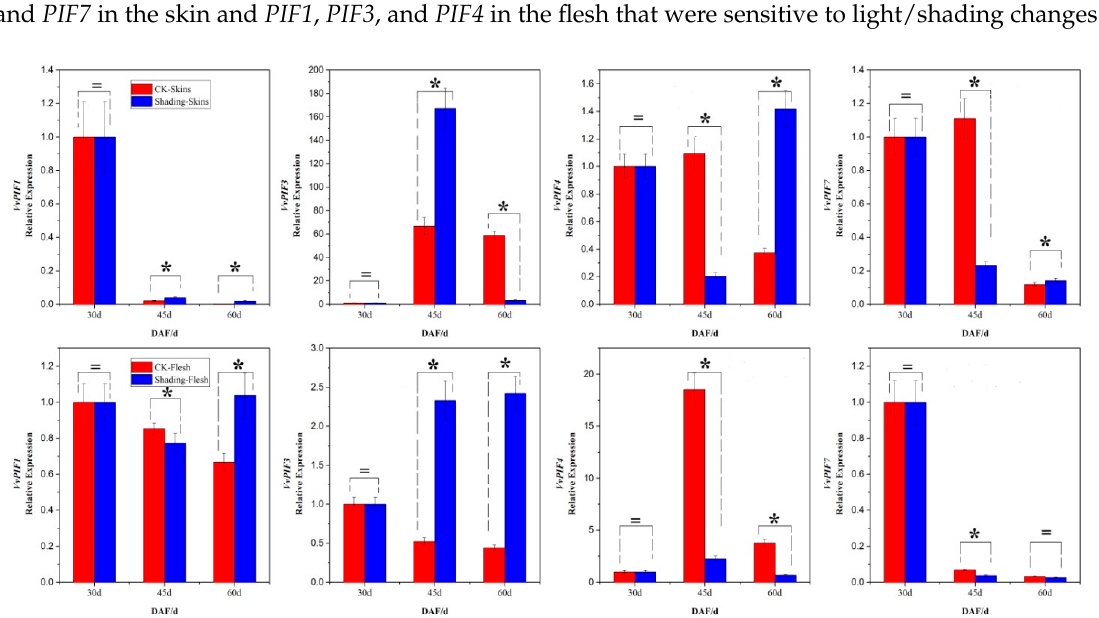
Figure 9. Relative expression levels of VvPIFs in the skin and flesh of SB under light/shading conditions. Stars indicate significant differences among different treatments ( p < 0.05) according to Duncan’s multiple test, while the equal sign means non-specific difference. DAF indicates days after flowering. Due to the low expression values of PIFs in these organs, expression levels were calculated based on the 2 − ∆∆ Ct method with the first stage sample chosen as a reference for convenience of observation.